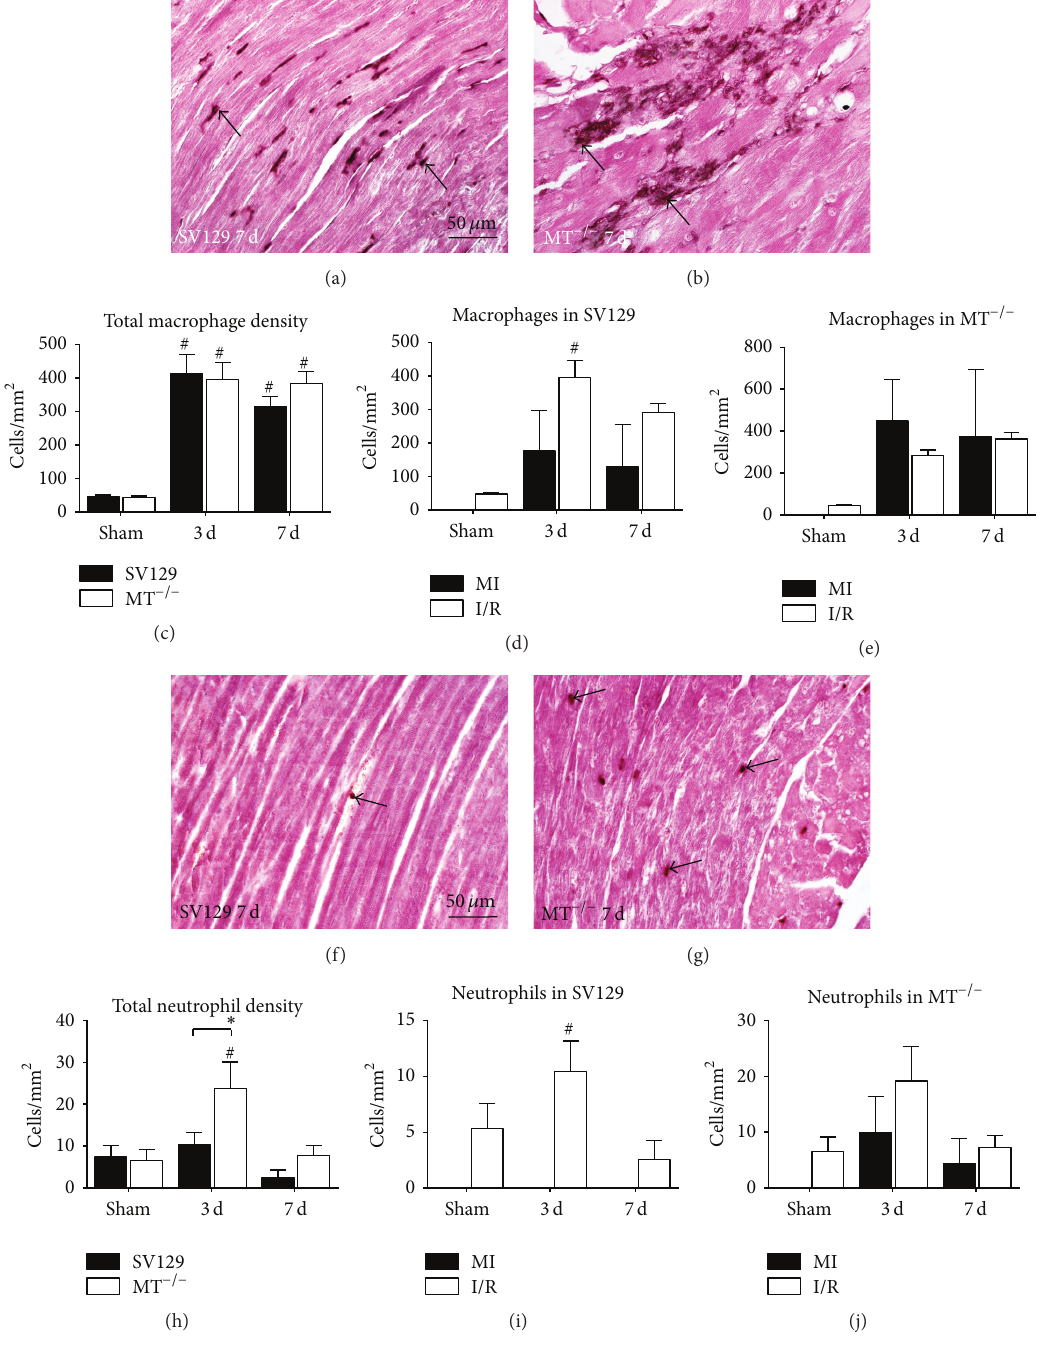
Figure 4: Macrophage and neutrophils infiltrate into areas of microinfarctions in MT −/− -hearts. MAC-2 staining of representative left ventricular sections after 7 days of (d) I / R demonstratespredominant interstitialmacrophage infiltration(arrow) inWT-hearts (a),in contrast to increased macrophage density in microinfarctions (arrows) in MT −/− -hearts (b). (c) Quantification of MAC-2 + cells shows increased macrophage infiltration after 3 and 7 days of (d) I / R in both genotypes. Differential analysis of macrophage accumulation revealed that macrophages were mainly located in the interstitial spaces in WT-hearts (d) but to an equal number in microinfarctions in MT −/− -hearts (e). Representative MCA771G stained sections of WT- (f) and MT −/− -hearts (g) after 7 days of I / R (arrows: neutrophils). (h) Quantification of MCA771G + cells showed higher neutrophil infiltration in MT −/− -hearts after 3 days of I / R compared to WT. Neutrophil distribution was comparable to macrophages (i and j). 𝑛 = 8–10/group; scale bars in (a), (b), (f), and (g): 50 𝜇 m; RT-qPCR using Taqman, mRNA expression is related to shams and GAPDH using comparative ΔΔ Ct-method; ∗ indicates P ≤ 0.05 between the genotypes; # indicates P ≤ 0.05 versus respective